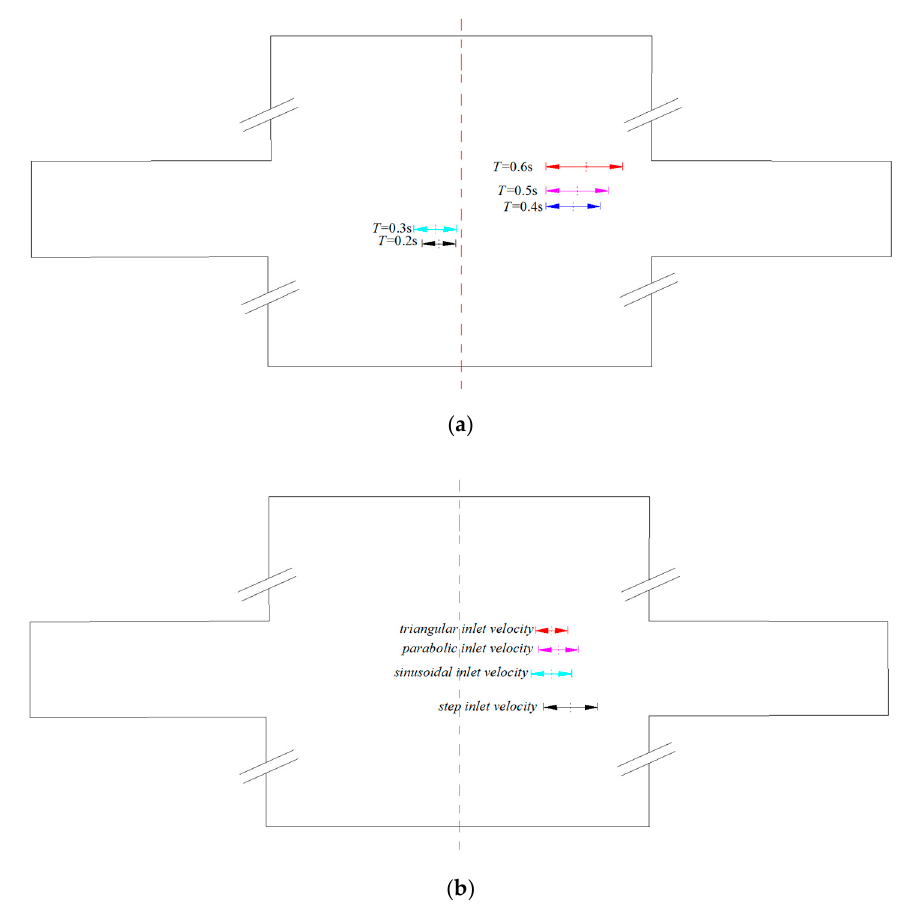
Figure 14. Impinging surface motion range by CFD model at different periods and flow patterns of inlet velocity variation, u m = 1.25 m/s, A = 0.25 m/s, L / D = 4 and ∆ ϕ = T/2 in one period. ( a ) effect of T on impinging surface motion range at step inlet velocity conditions; ( b ) effect of inlet types on impinging surface motion range at T = 0.4 s.